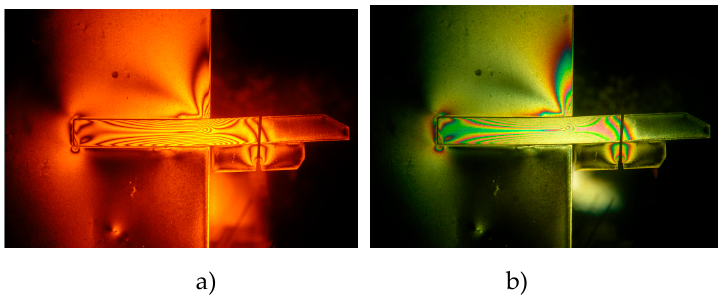
Figure 5. Typical isochromatic fringe of epoxy resin pile (No.1). ( a ) Isochromatic fringe under condition of monochromater, ( b ) isochromatic fringe under condition of white light.